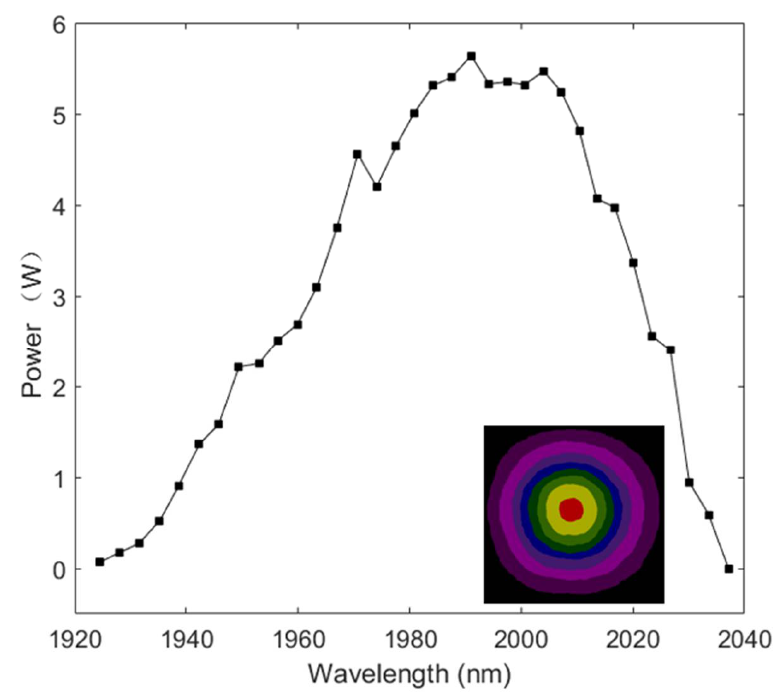
Figure 3. The output power of the MOPA system.